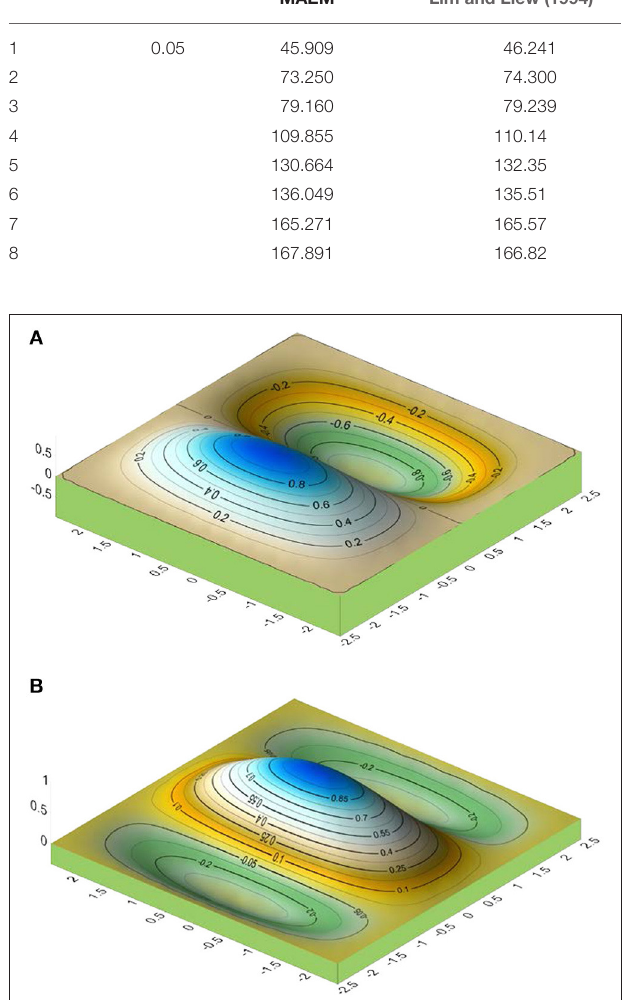
FIGURE 8 | (A) 1st vibration mode of the shell in Example 3-case (a). (B) 2nd vibration mode of the shell in Example 3-case (a).